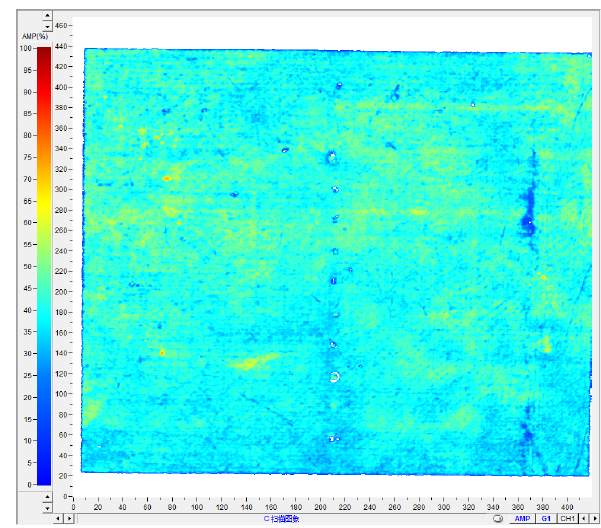
Figure 8: Photograph by C scan